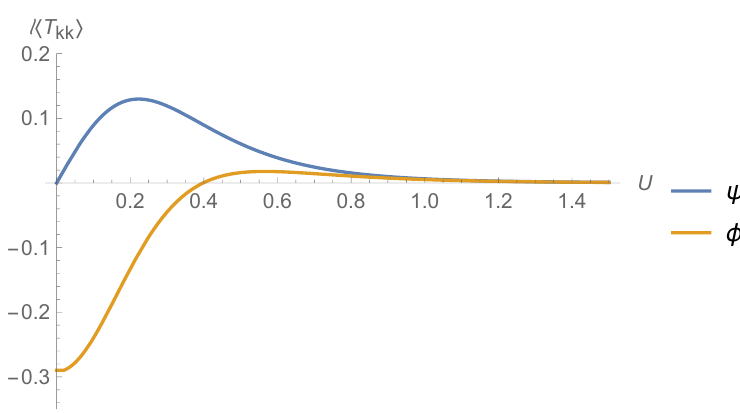
Figure 2 . Plot of ‘ h T kk i vs. U with k (cid:22) @ (cid:22) = @ U for a spinor (cid:12)eld and a scalar (cid:12)eld (cid:30) .